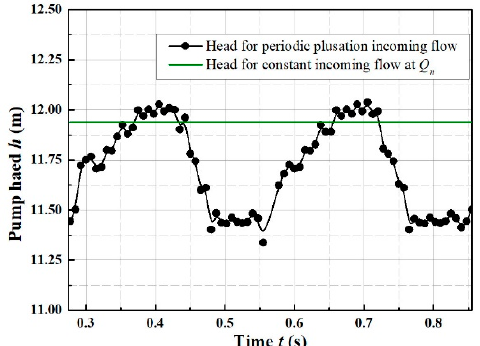
Figure 5. Head of pump under the periodic inlet pulsation flow rate.